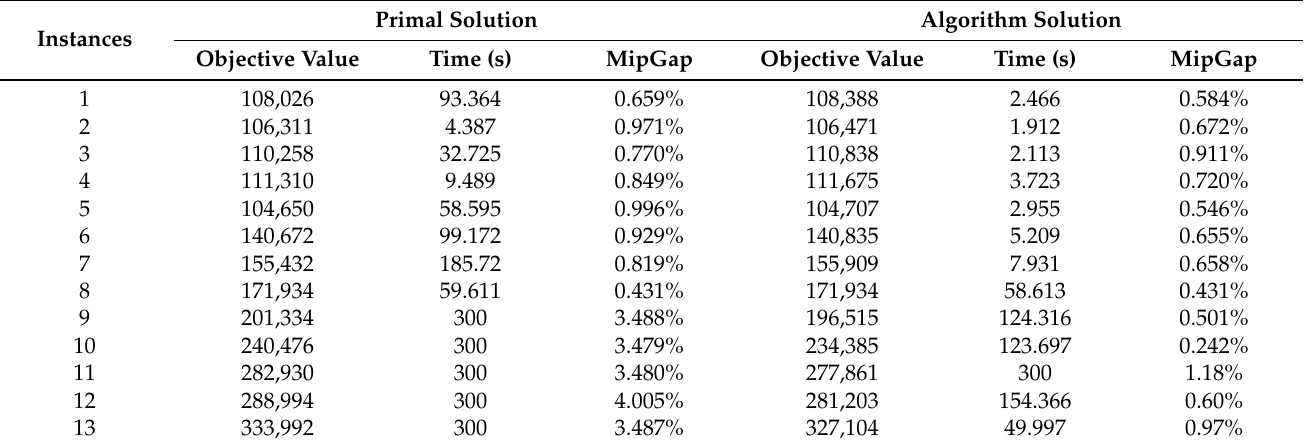
Table 3. Performancecomparisons over middle-scale instances. Maximum computational time was 300 s.